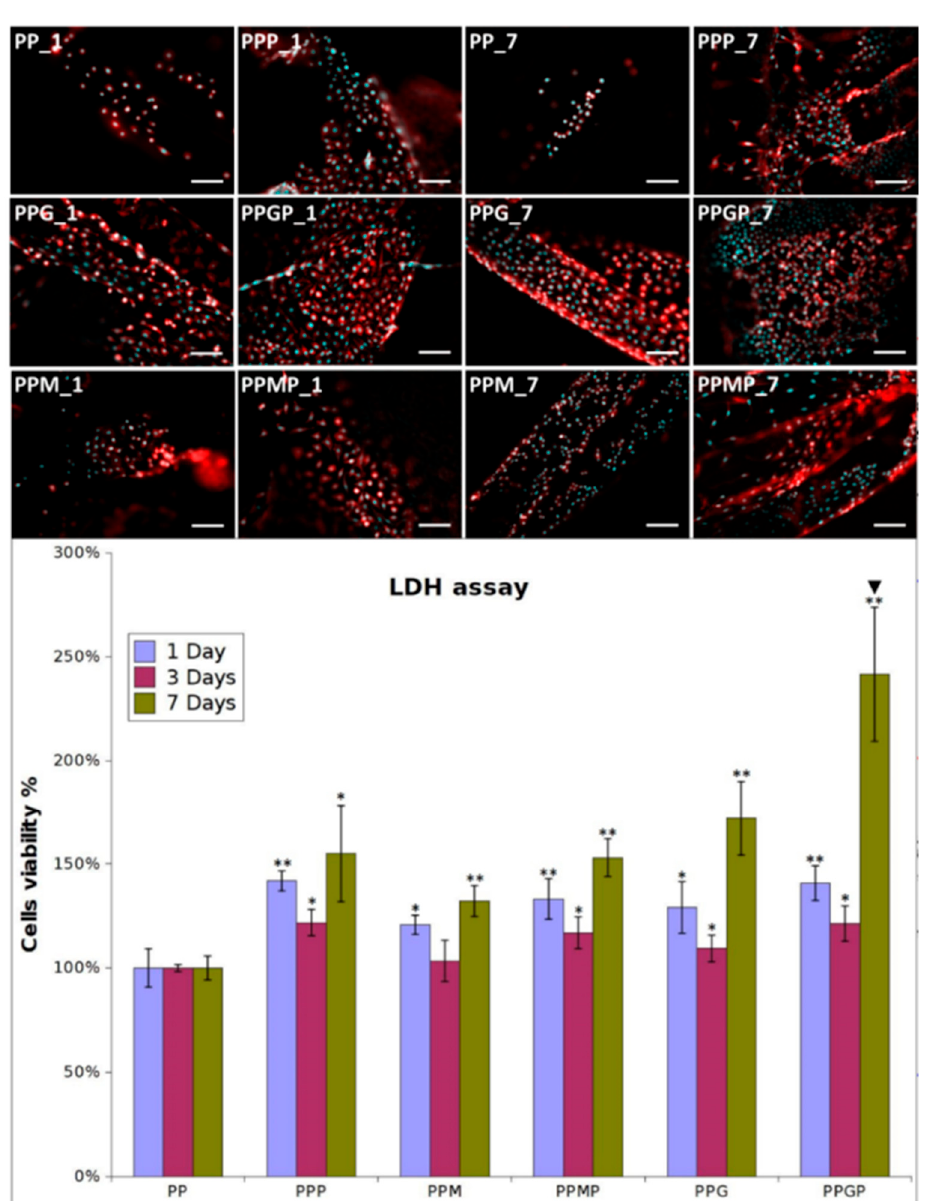
Figure 3. Representative optical microscopy images of fibroblasts on coated meshes at one and seven days post-culture (nuclei stained with DAPI, cytoskeleton stained with Phalloidin-TRICT; magnification 20×, scale bar 100 µm); LDH assay at one, three and seven days post-seeding ( n = 3, * p ≤ 0.05, ** p ≤ 0.01, ▼ p ≤ 0.01 for PPP vs. PPMP and PPGP, respectively); note that different cell density was used at seeding for the three experimental times.